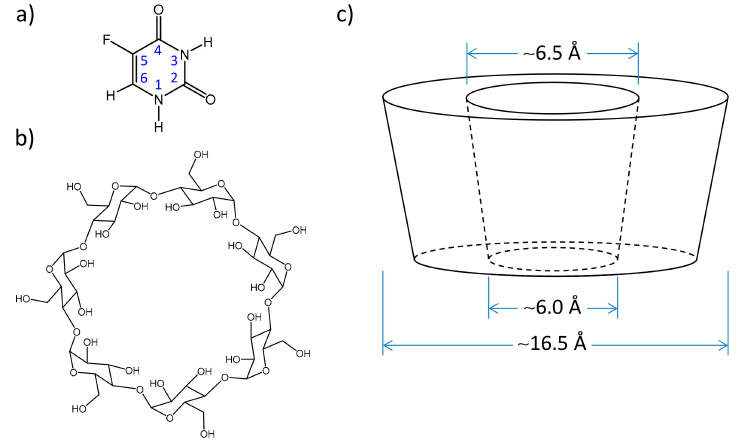
Figure 1. Structure and atom numbering of 5-fluorouracil (5-FU) ( a ), chemical formula of β -cyclodextrin ( β -CD) ( b ) and its dimensions ( c